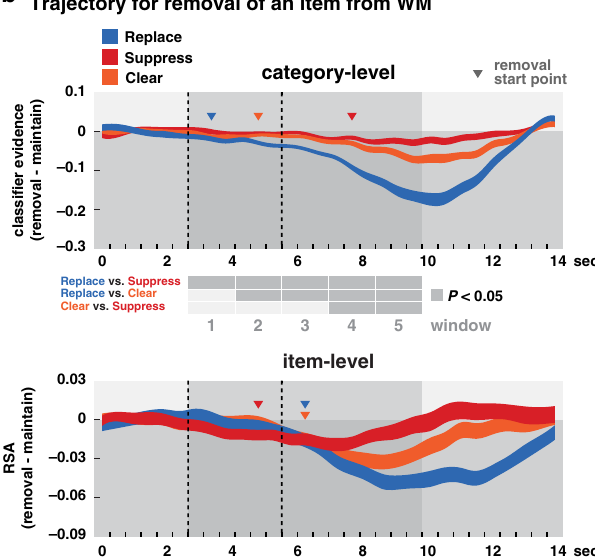
Fig. 4 Neural decoding of WM representations. a Group-averaged category-level fMRI pattern classi fi er evidence scores are shown for 14 s after the onset of each trial, shown separately for the item on maintain trials (green), the item being replaced on replace trials (blue), the item that serves as a replacement on replace trials (light blue), and an empirical baseline of trial-irrelevant items selected randomly from suppress and clear trials (gray). Data between discrete data points at each TR (460 ms) were interpolated and are presented as ribbons whose width represent the mean ± 1 SEM for n = 50 participants. Triangle indicates the replace-new start point de fi ned as the fi rst 3-TR window (1.38 s) in which the decoding evidence for the replace-new item was reliably greater than baseline. b Category-level (top) and item-level (bottom) decoding evidence for each of the three removal operations, replace (blue), suppress (red), and clear (orange), subtracted from that for maintain trials at each timepoint. Deviations below zero indicate a reduction in information in brain activity below maintenance of the to-be-removed item. Triangles indicate the removal start point for each condition, de fi ned as the fi rst 3-TR window (1.38 s) in which the decoding evidence for one of the trial types was reliably below zero (start point for classi fi er evidence: replace, P = 8.5e − 04; clear, P = 8.73e − 04; suppress, P = 0.001; for RSA: suppress, P = 0.008; replace, P = 0.002; clear, P = 0.002). Width of the data ribbons indicates the mean ± 1 SEM for n = 50 participants. Statistical comparisons between conditions are indicated in the charts below each plot with dark gray cells indicating statistical signi fi cance, * P < 0.05, two-sided, repeated measures pair-wise T -tests (FDR corrected). For the category-level trajectories of classi fi er evidence, the statistical comparisons were P s < 3.95e − 04 for replace vs. suppress across the signi fi cant windows, P s < 0.002 for replace vs. clear, and P s < 0.028 for clear vs. suppress. In the item-level trajectories of RSA correlations, the statistical comparisons were P s < 4e − 04 for replace vs. suppress, P = 4.41e − 04 for replace vs. clear, and P = 5.35e − 04 for clear vs. suppress. See Supplementary Table 3 for full statistics. Source data are provided as a Source Data fi